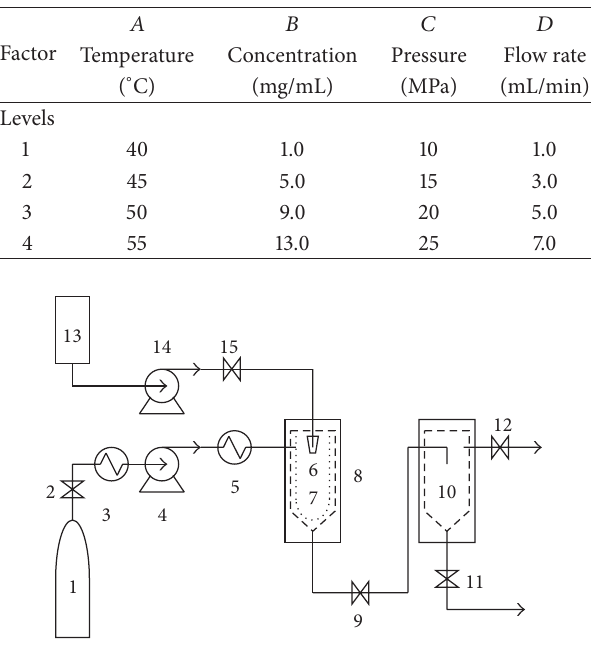
Table 1: The factors and levels of the orthogonal array design.